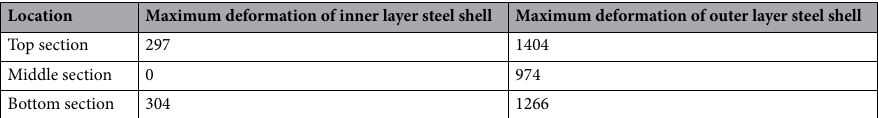
Table 3. Maximum deformation of steel shell during concrete pouring (Unit: µ m